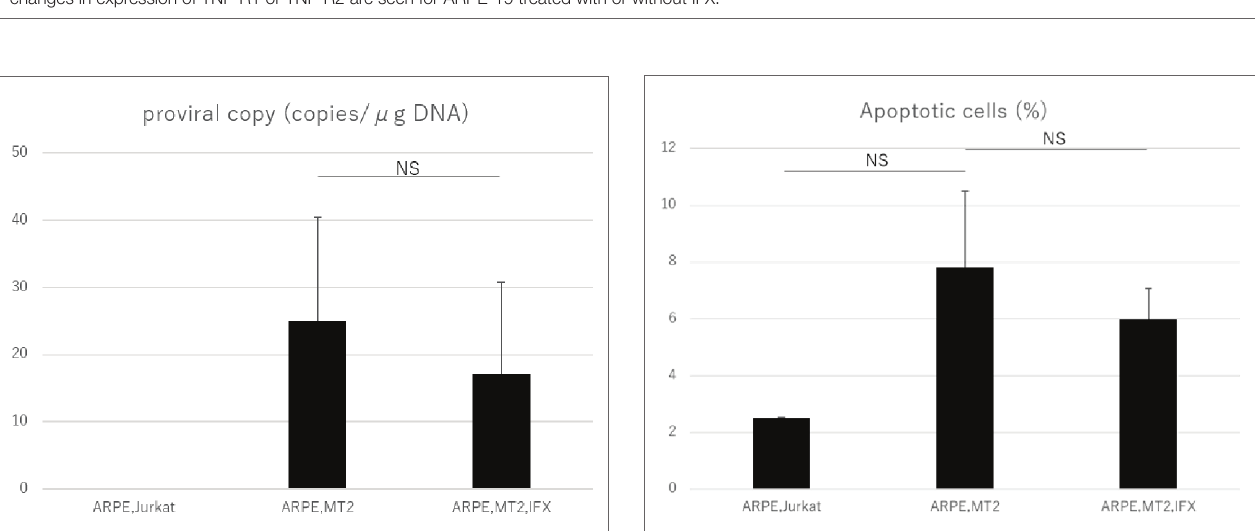
FIGURE 3 | (A) Histogram of TNF-R1 and TNF-R2 on ARPE-19 in FACS analysis. Histograms of TNF-R on ARPE-19 and ARPE-19 after co-culture with MT2 with or without IFX. Results are representative of four experiments. (B) Expression of TNF-R1 and TNF-R2 on ARPE-19 in immunohistochemical staining. No significant changes in expression of TNF-R1 or TNF-R2 are seen for ARPE-19 treated with or without IFX.